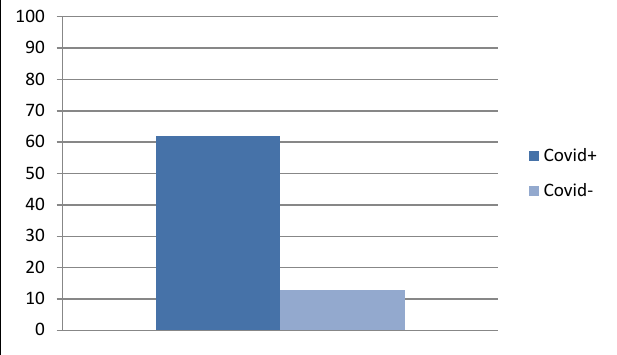
FIGURE 2 | Percentage of number of people with at least one pathological score in NPS tests.